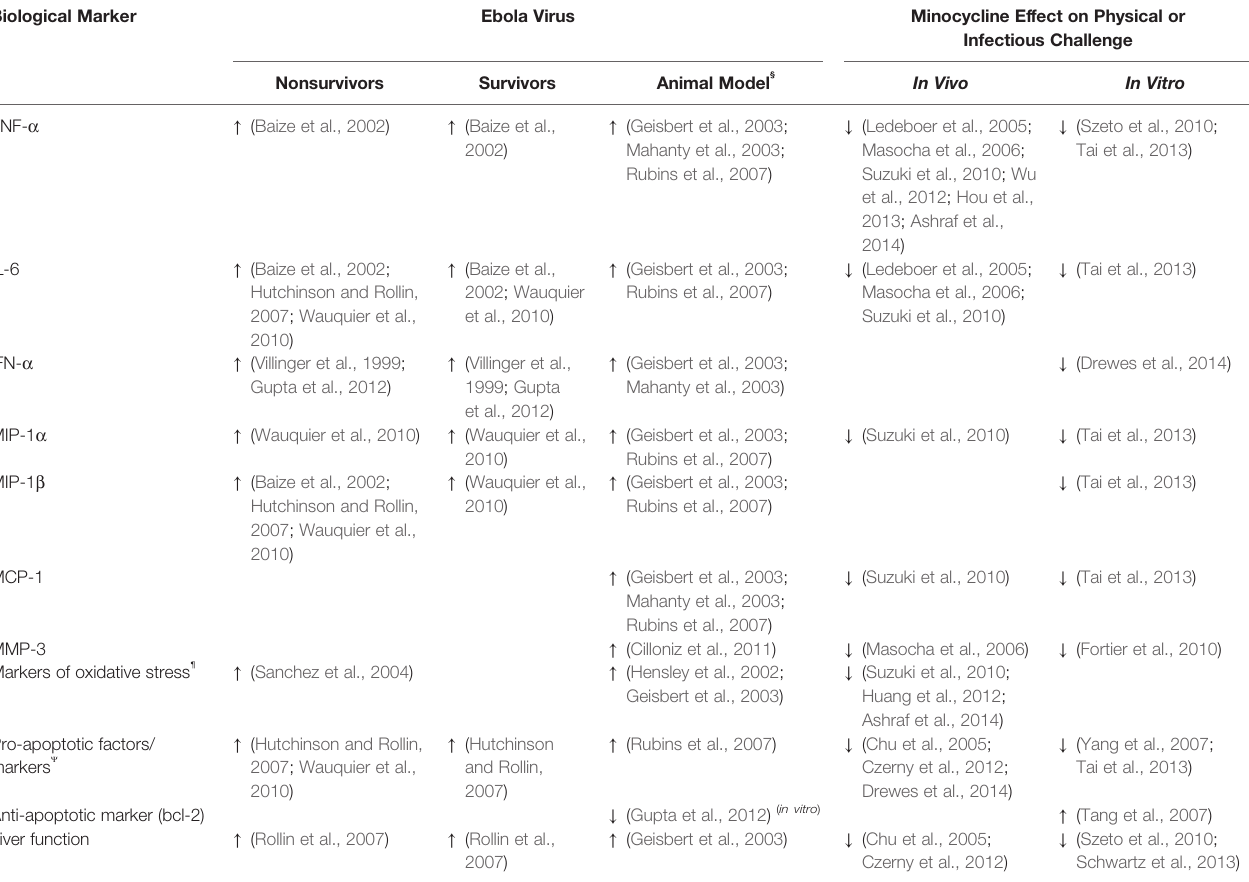
TABLE 1 | Comparison of the Effect of Ebola Virus and Minocycline on Selected Biomarkers. Biological